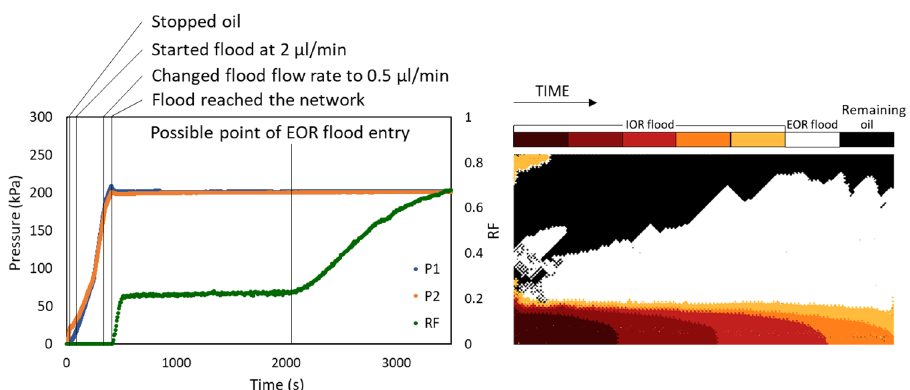
Figure 7. Dynamic pressure and RF (left) and a time-lapse of the displacement pattern (right) for crude oil C aged for 2 h and displaced first by HS-NaCa and then LS-NaCa AOT at 80 °C and 2